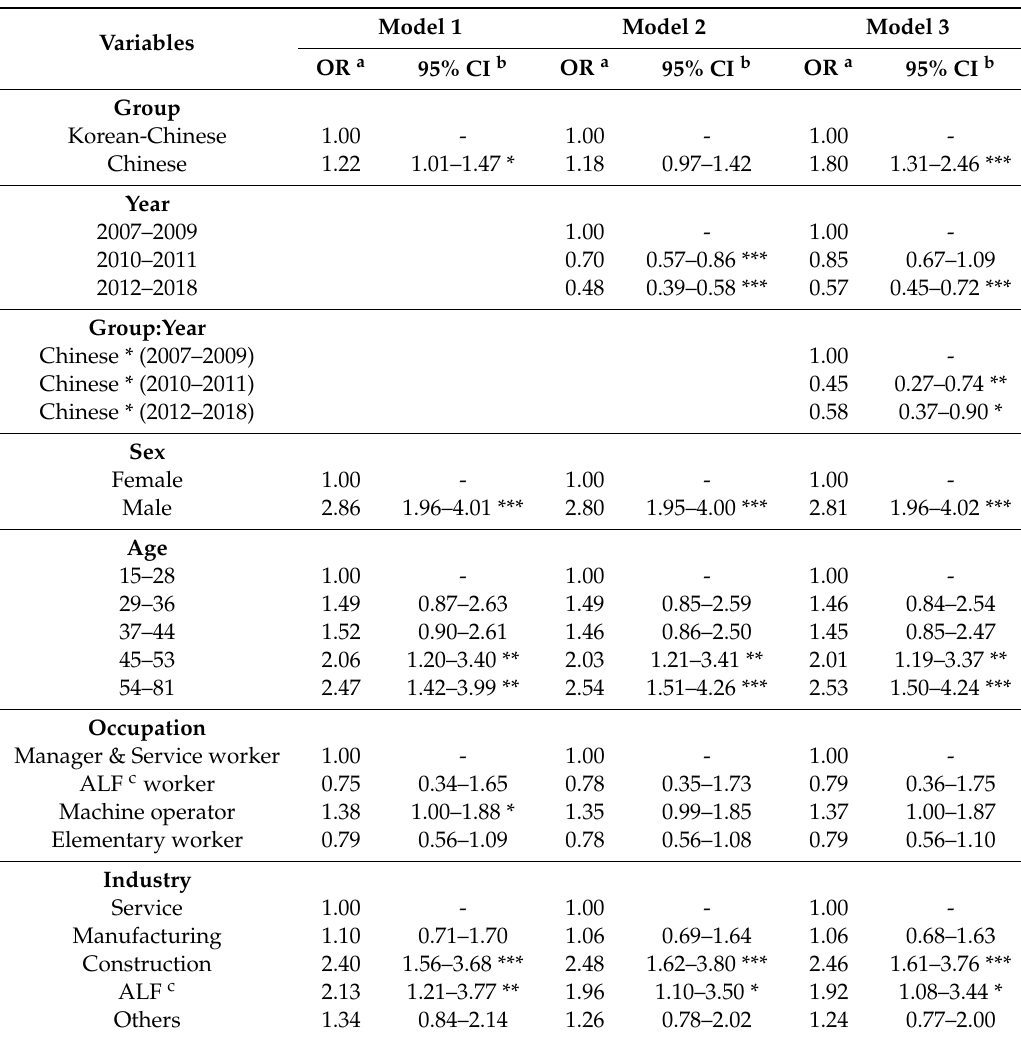
Table 4. Odds ratios for fatality rate of occupational injuries between Korean-Chinese and Chinese migrant workers by